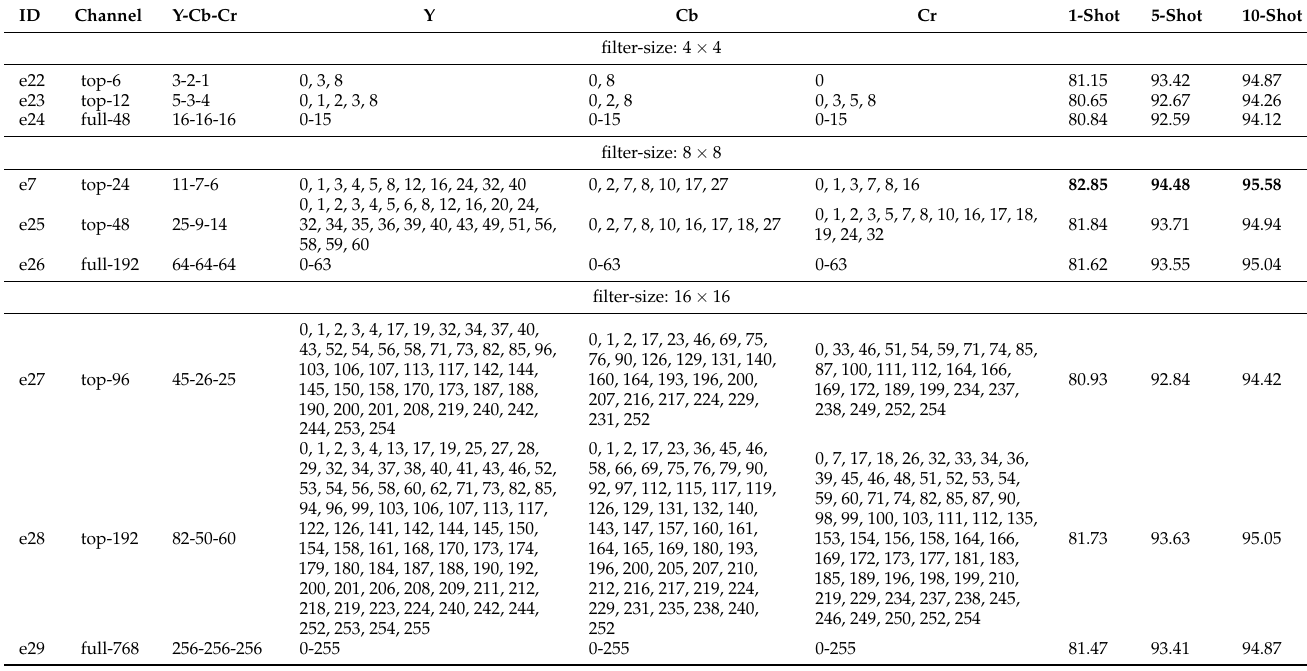
Table 5. The results of different filter-sizes and top-N frequency selections. The full channels of filter-size 4 × 4, 8 × 8 and 16 × 16 were 48, 192 and 768, respectively. ( f θ : Resnet12; method: f; data: